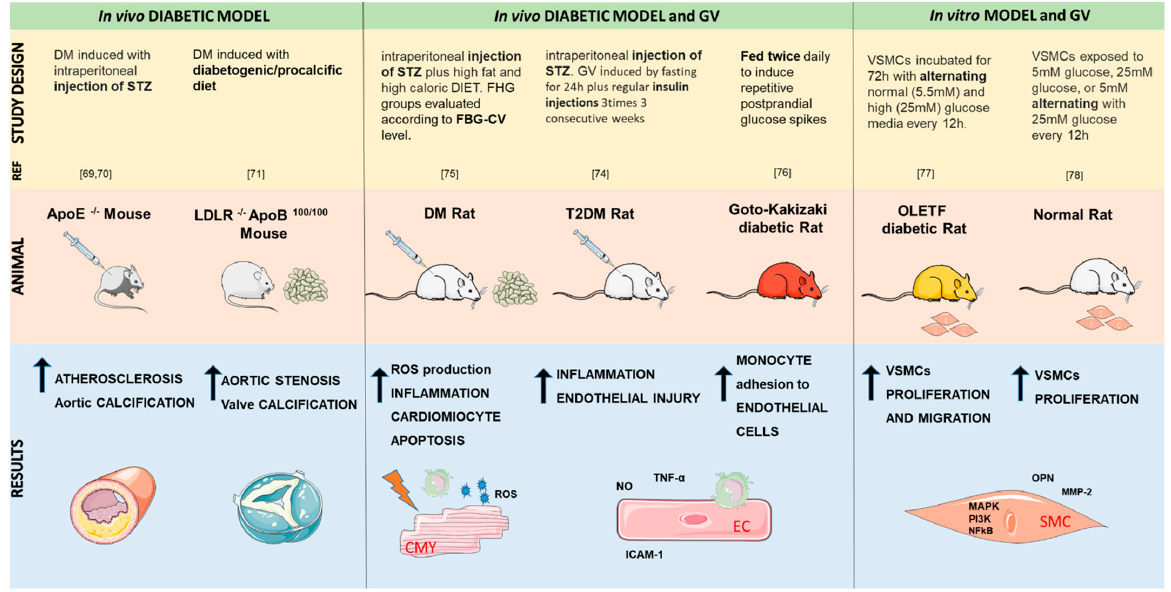
Figure 1. In vivo mouse and rat models used to study the effects of glucose in the cardiovascular system and the respective obtained results.